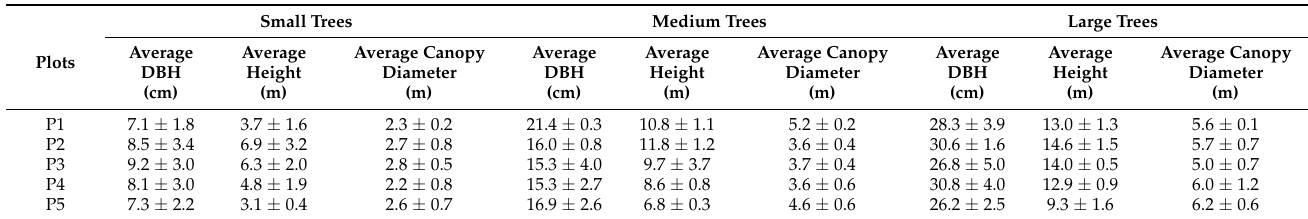
Table 2. Characteristics of sample trees of each size class in the five Qinghai spruce plots (mean value ± standard